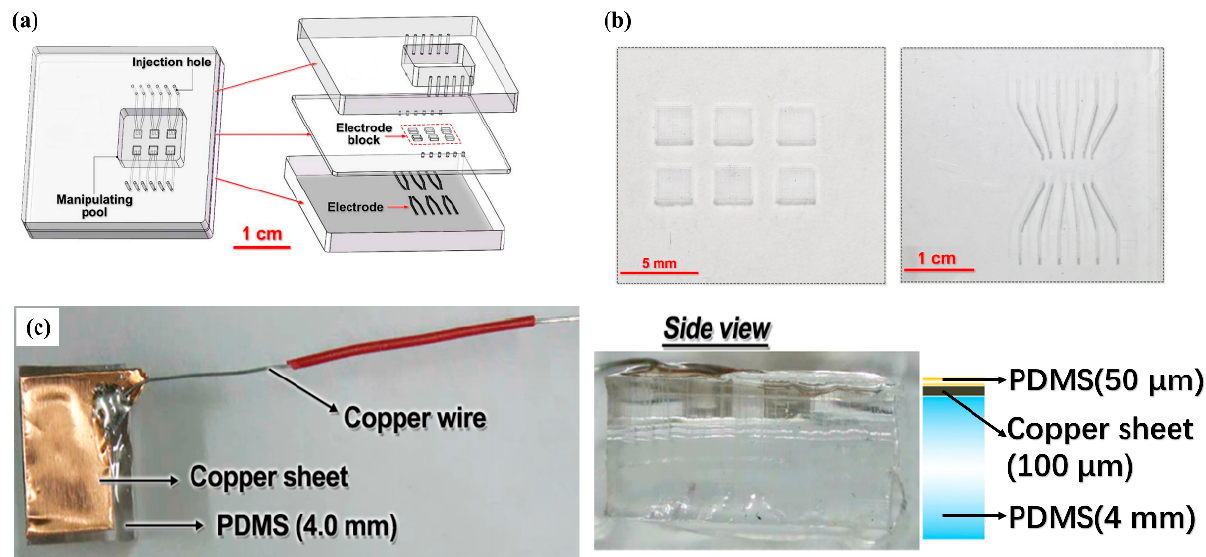
Figure 1. Design schematic and photo of the droplet driving device. ( a ) Three layers of the channel structure; ( b ) photo of the laser ablation channel; ( c ) photo of the copper sheet electrode.